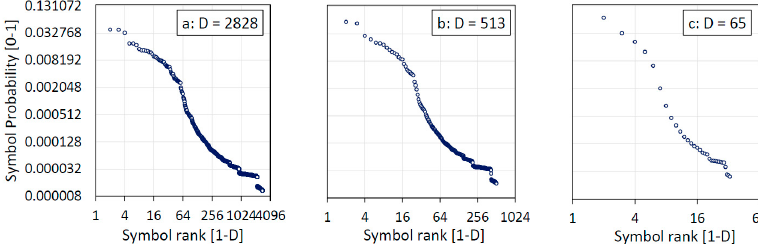
Figure 1. The profile representing a Musical Instrument Data Interface (MIDI) version of Beethoven’s 9th Symphony 3rd Movement. ( a ) shows the full fundamental scale description having 2828 different symbols; ( b , c ) represent the degraded versions of the same profile with 513 and 65 symbols respectively.